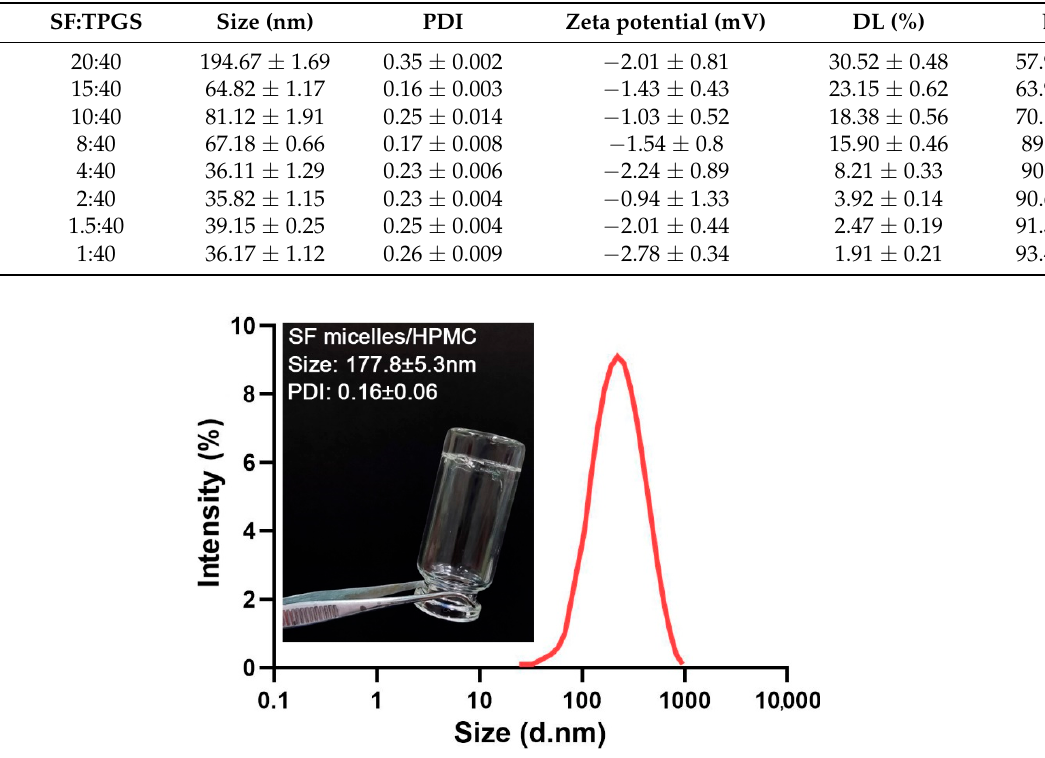
Figure A4. Size distribution of SF micelles dispersed in HPMC.